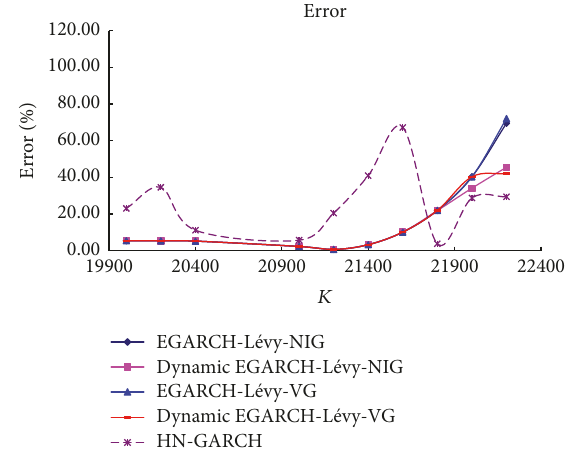
Figure 3: The relationship between models’ error and exercise price in short-term options.